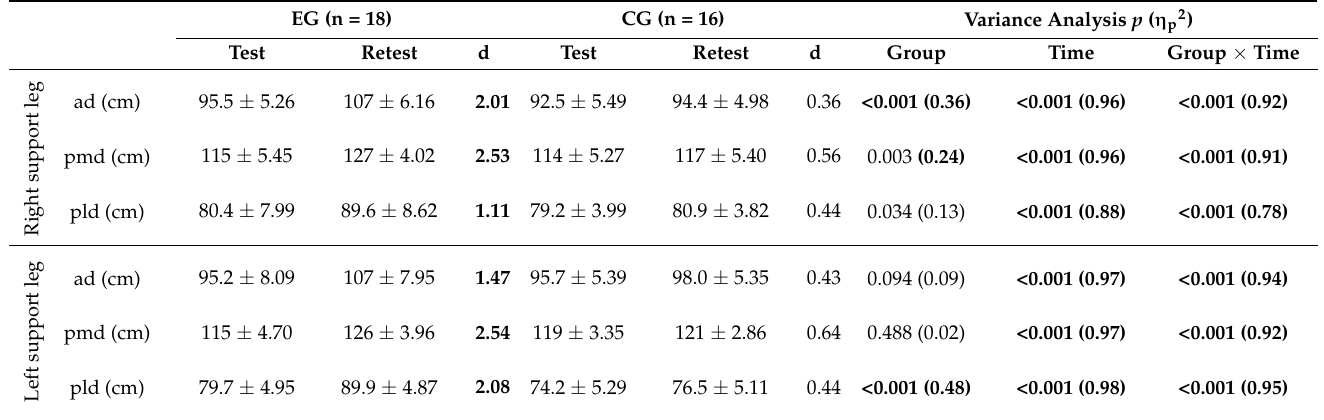
Table 6. Y-Balance test performances depending on groups (EG vs. CG) before and after 8-week intervention. Anterior direction = ad; Posteromedial direction = pmd; Posterolateral direction = pld; Meaningful effects (criteria: p < 0.05 and η p2 > 0.15 and d > 0.80) and the largest effect sizes for each parameter are highlighted in